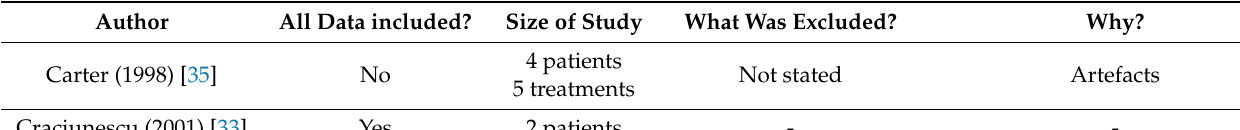
Table 4. Exclusions of data from clinical studies